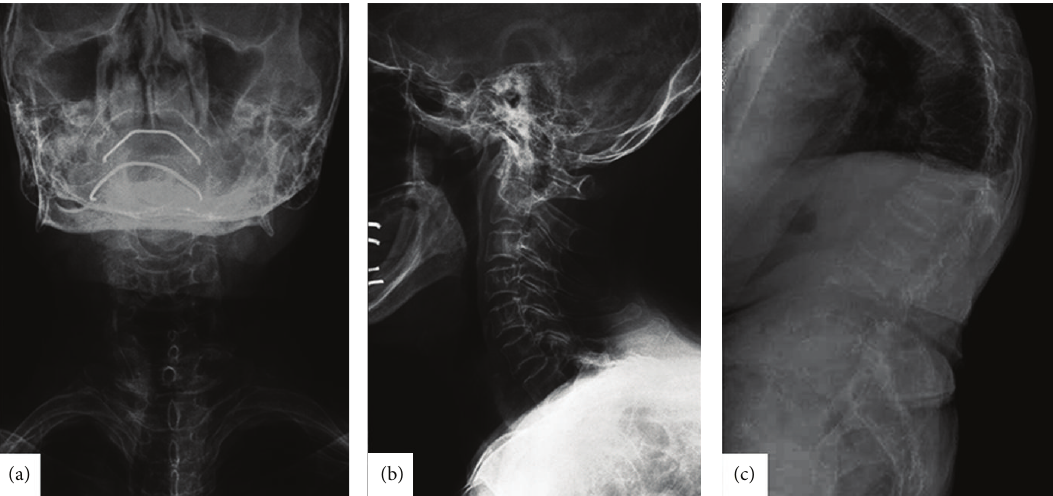
Figure 1: Anteroposterior (a) and lateral (b) standard radiographs of cervical spine revealed degenerative spondylosis but failed to reveal apparent fracture in cervical spine. Lateral standard radiographs of thoracolumbar spine revealed marked thoracic kyphotic deformity due to multiple compression fractures (c).